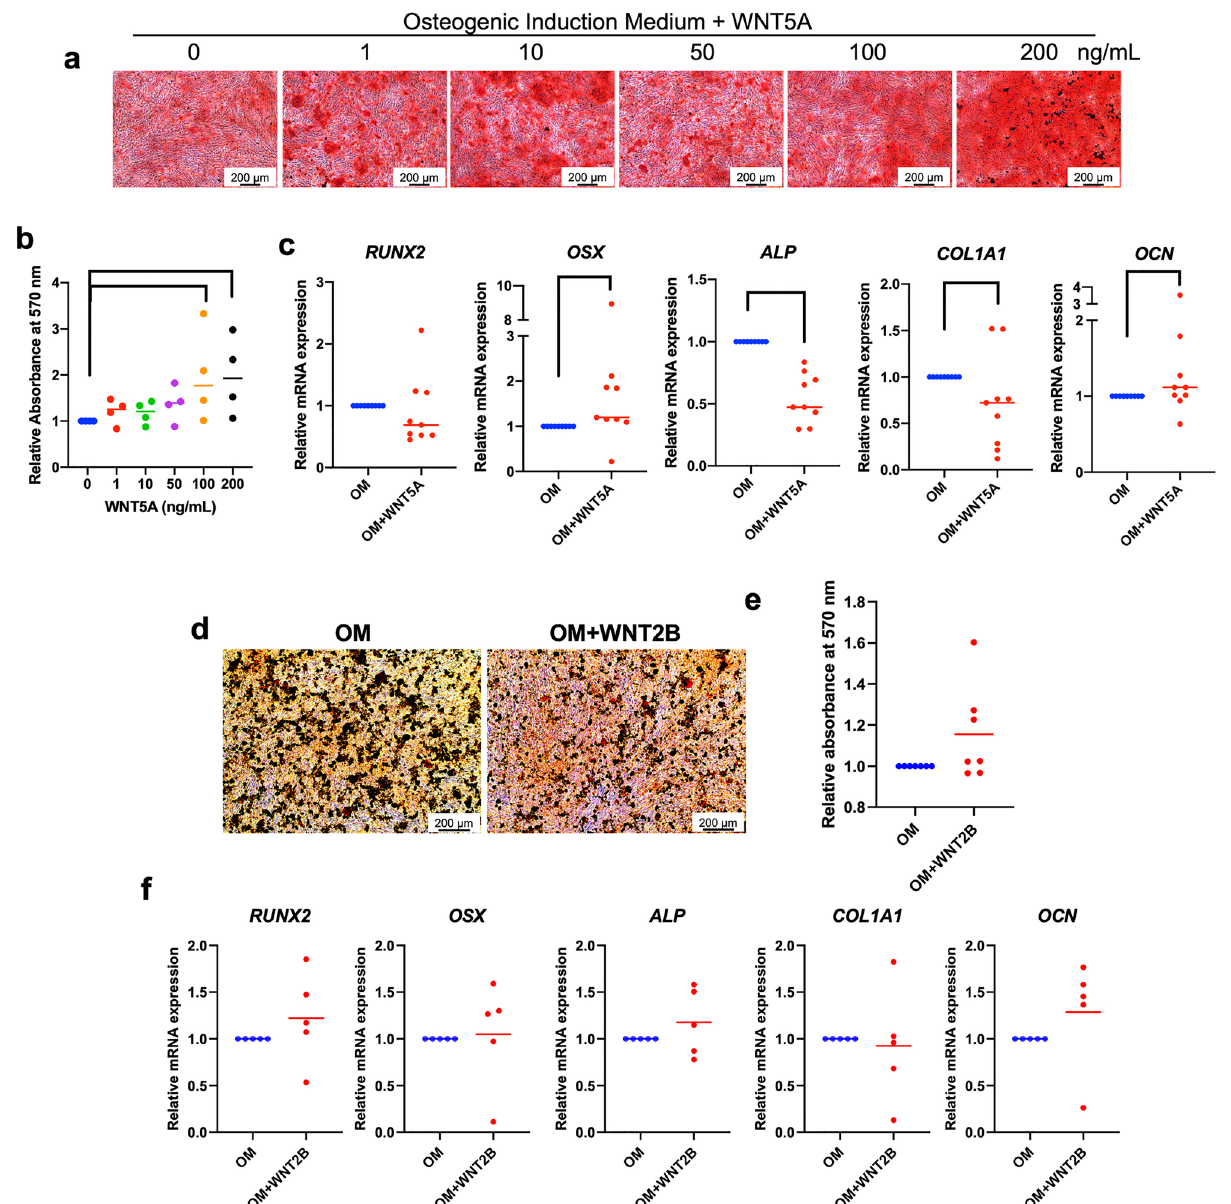
Figure 4. WNT5A enhances the osteo/odontogenic differentiation in hDPSCs. The cells were maintained in osteo/odontogenic medium with either ( a – c ) recombinant WNT5A or ( d – f ) WNT2B supplementation. Cells cultured in osteo/odontogenic medium were used as the control. ( a and d ) Mineral deposition was evaluated at day 14. ( b and e ) The solubilized staining was measured and quantitated. ( c and f ) The mRNA levels of osteo/ odontogenic marker genes were measured using real-time polymerase chain reaction on day 7. Bars indicate a significant difference between groups ( p <